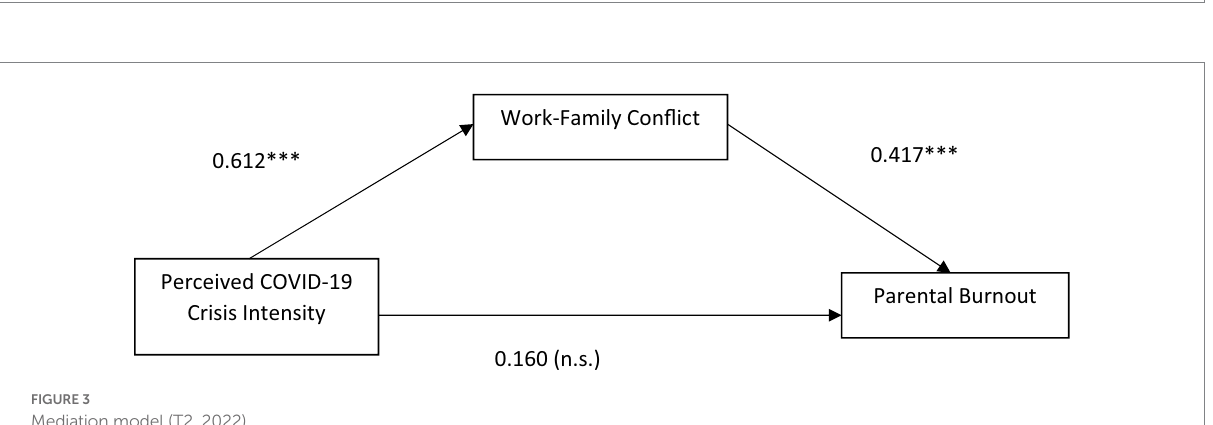
FIGURE 2 Mediation model (T1, 2021).